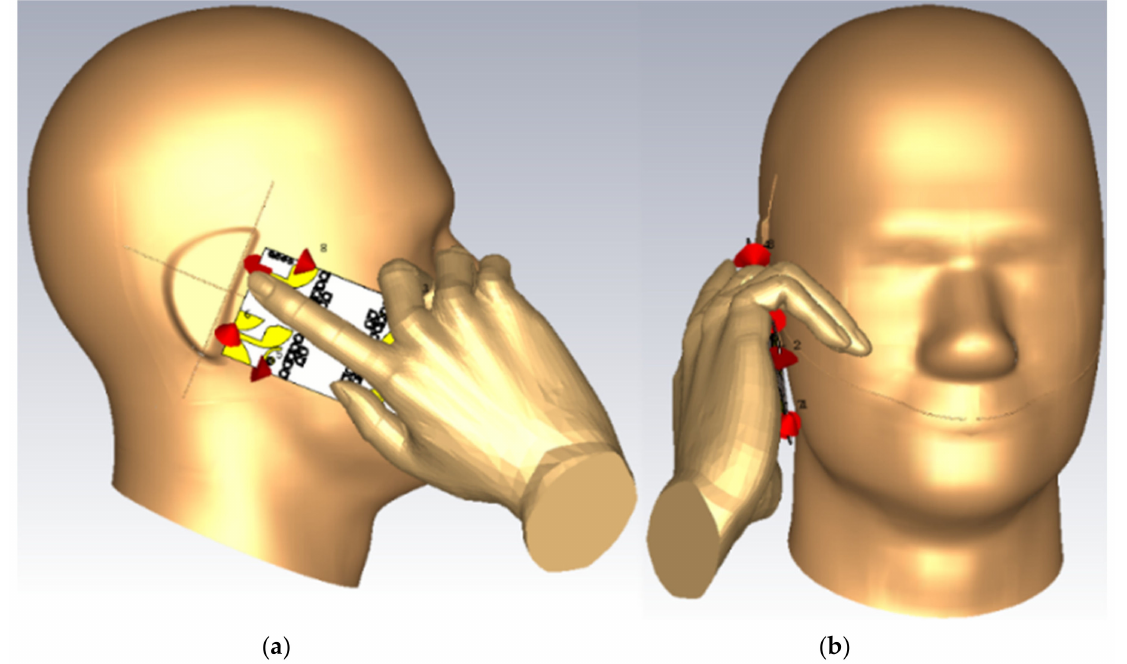
Figure 21. The proposed handset MIMO on the human head model: ( a ) side view, and ( b ) front